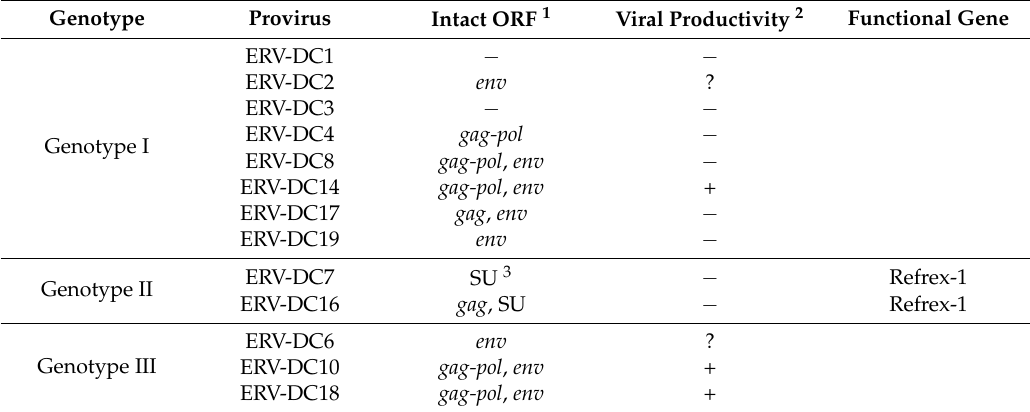
Table 1. Characteristics of each domestic cat endogenous retrovirus (ERV-DC) provirus.